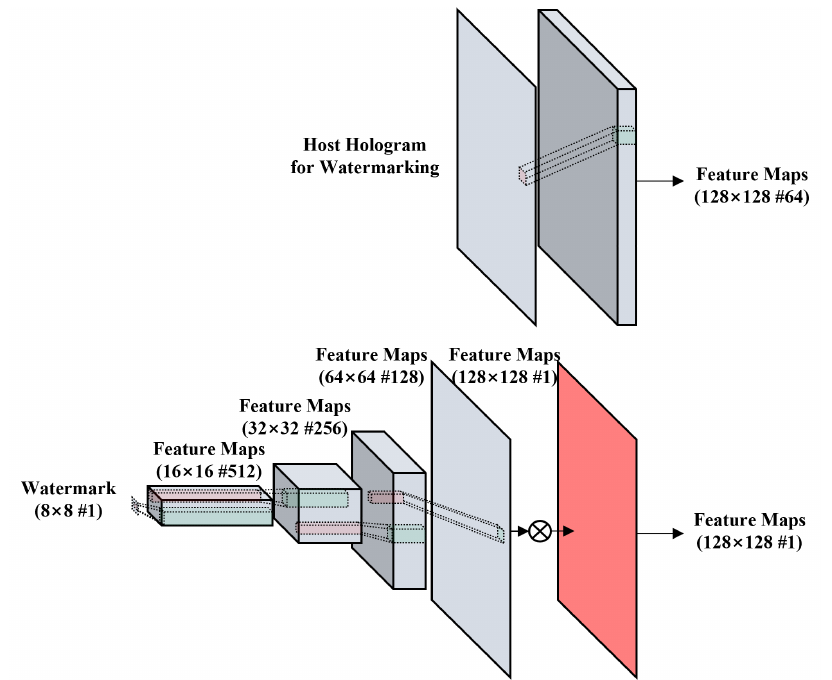
Figure 2. Network structure of the resolution-converting network